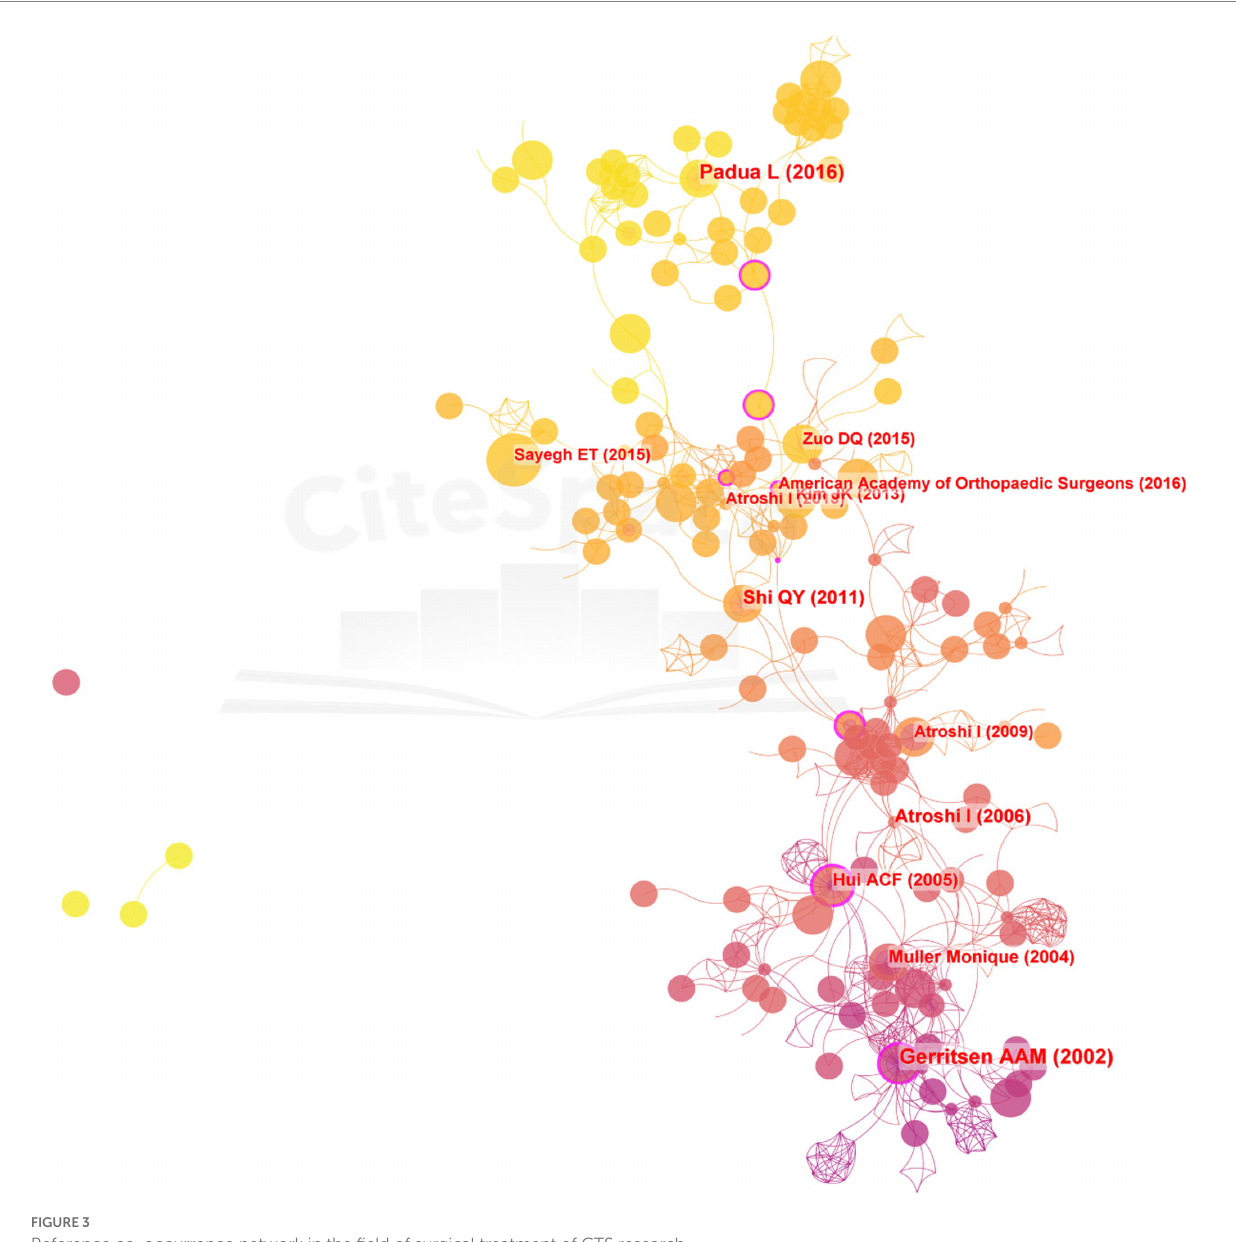
FIGURE 3 Reference co-occurrence network in the field of surgical treatment of CTS